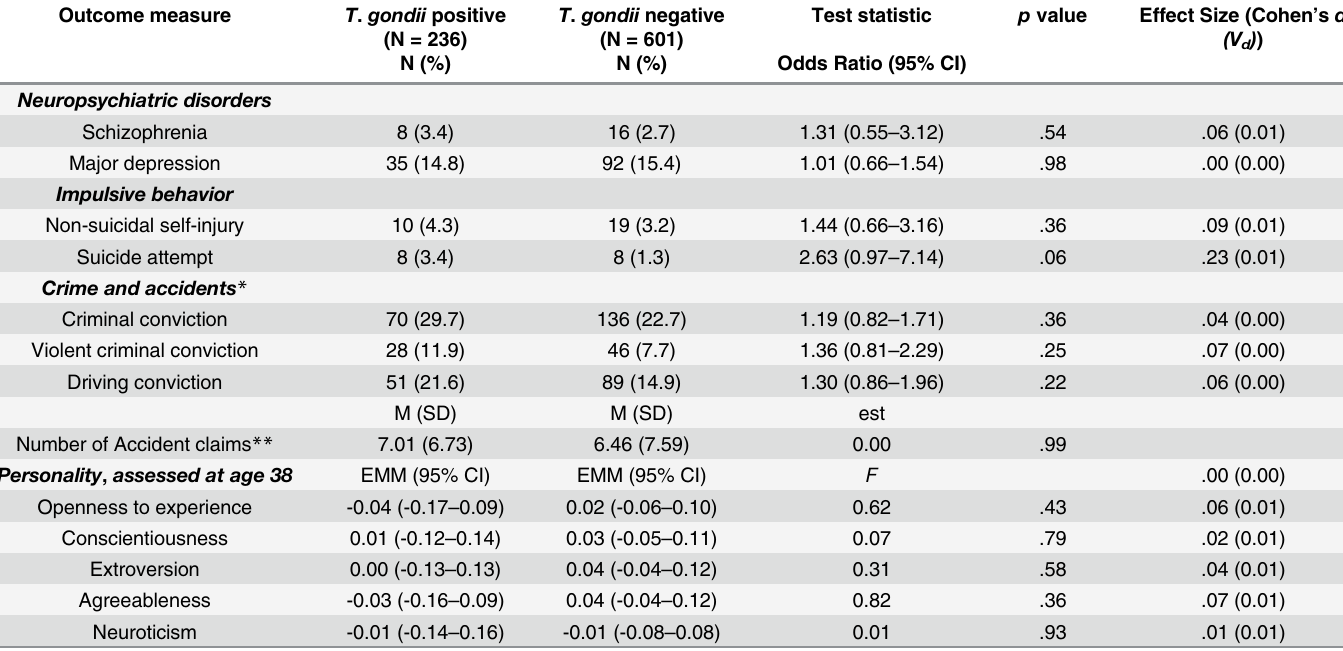
All tests are controlled for sex. N (%) represents the number and percent of individuals within each seropositivity group presenting with each phenotype. Personality scores are standardized to Mean = 0 and Standard Deviation =